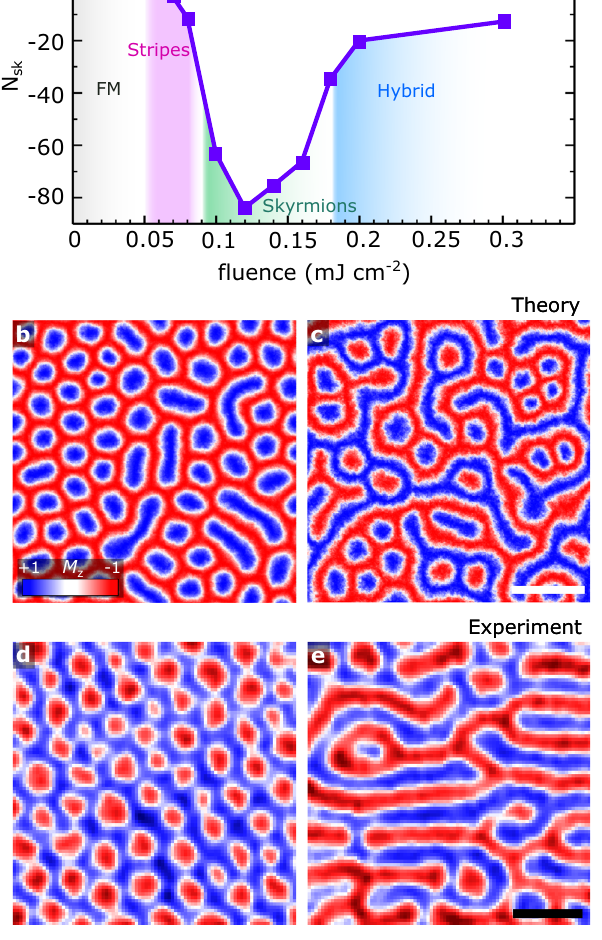
Fig. 2 | Fluence-dependent spin textures. a Final topological charge ( N sk ) versus energy fl uence(mJ cm − 2 ) ofthe applied laser. The different energies determine the spin states created in CrGeTe 3 within the range considered: spin polarised ferro- magnetic (FM), magnetic stripes, skyrmions and hybrid (stripes and skyrmions coexisting). In each case, CrGeTe 3 was in a spin-polarised saturated state ( M z =1) priortothelaserpulse. b – c Snapshotsofthesimulationresultsfor0.10mJcm − 2 and 0.30mJ cm − 2 , respectively. The out-of-plane magnetisation M z after 3 ns relaxation followingasinglelaserpulseisused.Thewhitescalebaris50nm. d,e Experimental results obtained via WFKM after 100 and 10 laser pulses, respectively. The black scale bar is 5 μ m and the laser fl uence is 16mJ/cm 2 . The measurements were per- formed at 18.5K. A 25mT magnetic fi eld is